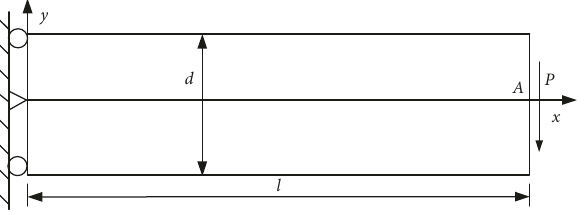
Figure 2: Regular and irregular meshes for the patch test: (a) regular; (b) irregularity coefficient α 0 . 4. (d) irregularity coefficient α r (cid:31) Table 1: Displacement error norm of numerical results for the standard patch test on different meshes. Solution FEM NS-FEM GS-FEM Regular 7.5426 E Irregular, α r 0 . 2 (cid:31) Irregular, α r 0 . 3 (cid:31) 0 . 4 Irregular, α r (cid:31)